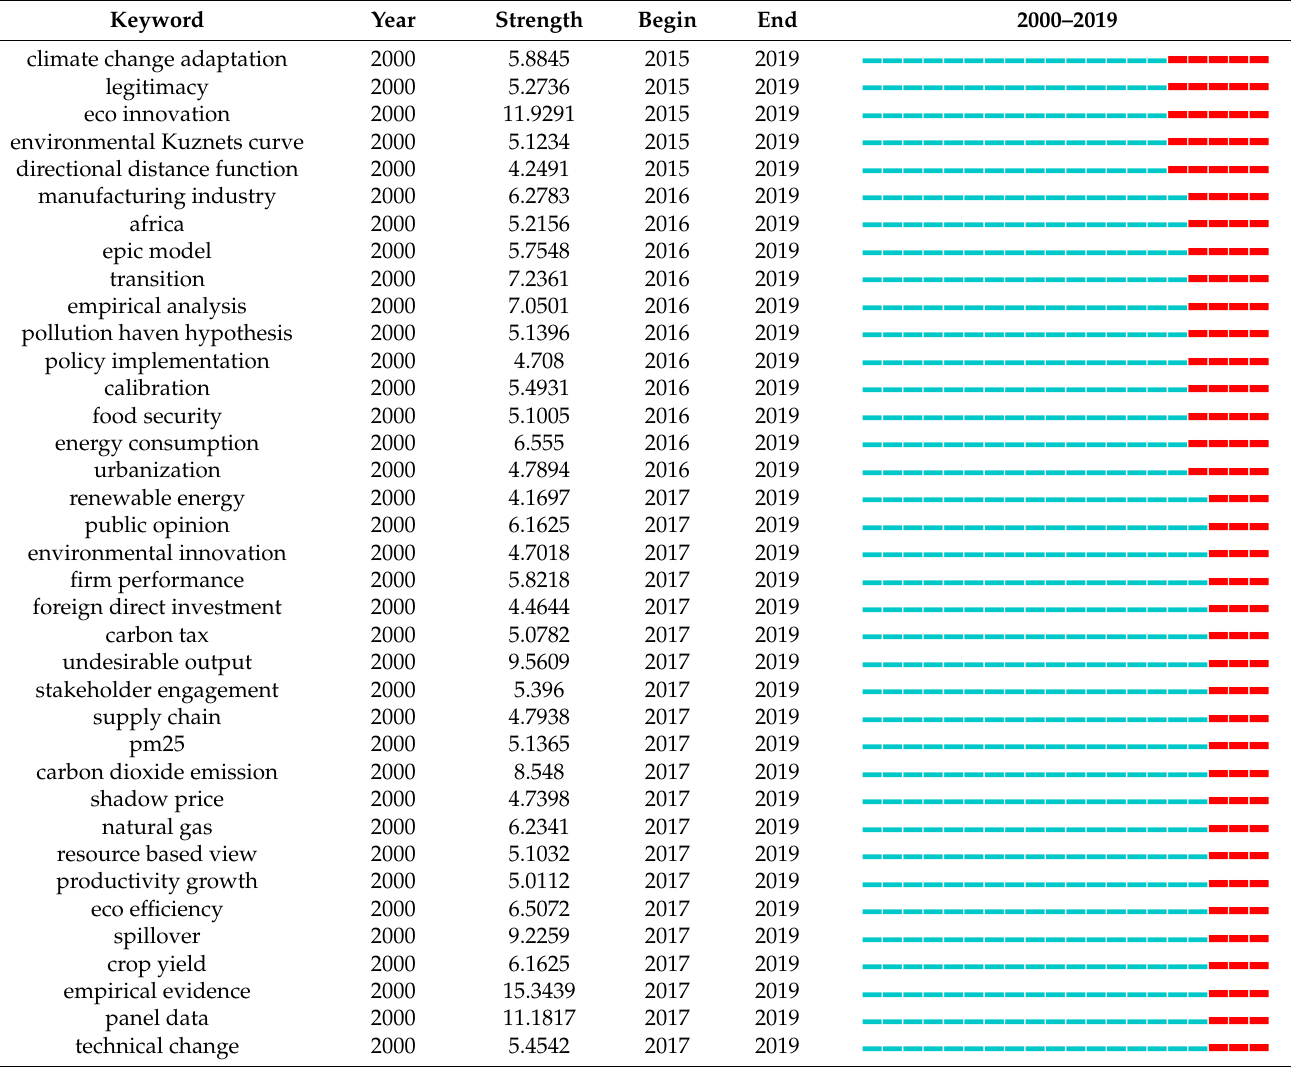
Table A2. The burst strength of keywords (part). The blue line represents the general time period and the red line represents the specific time period for keywords burst.